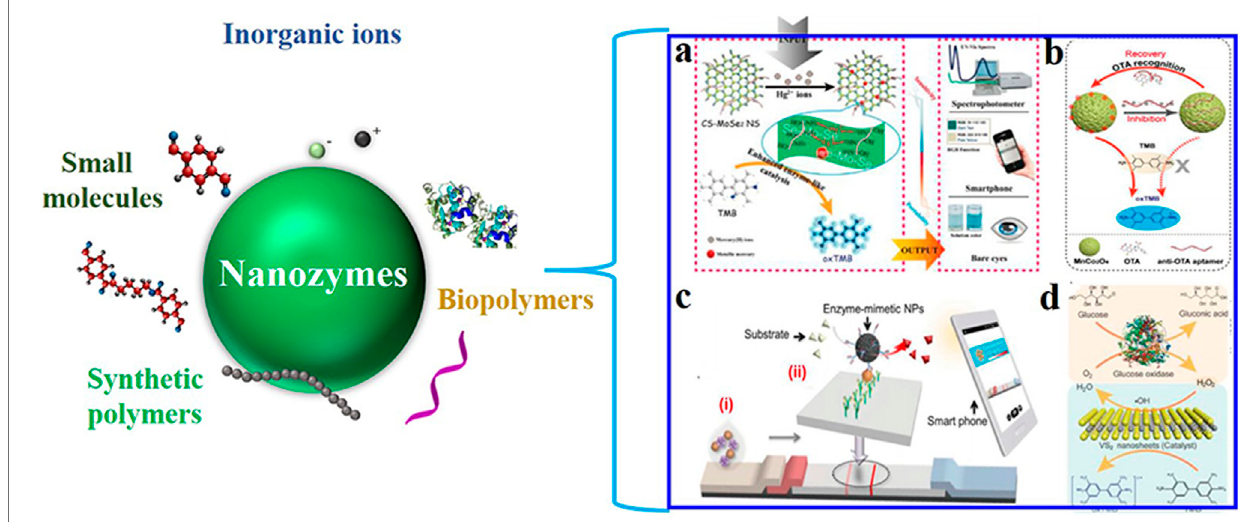
FIGURE 6 | Modi fi cation of nanozymes and their application in constructing analytical techniques ( (a) : Huang et al., 2019b; (b) Huang et al., 2018a; (c) Kim et al., 2015; (d) Huang et al., 2018b).